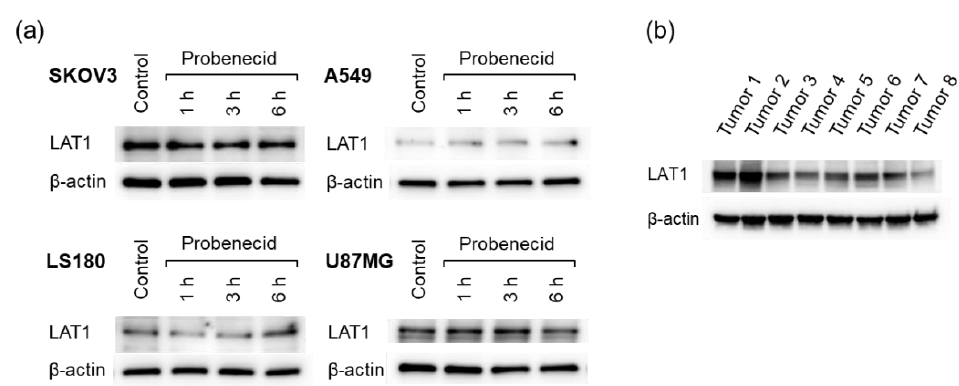
Figure 5. LAT1 expression in cell lines and excised tumors. ( a ) Four cell lines (SKOV3, A549, LS180, and U87MG) treated with probenecid (1 mM) and ( b ) SKOV3 tumors excised from eight tumor- bearing mice.